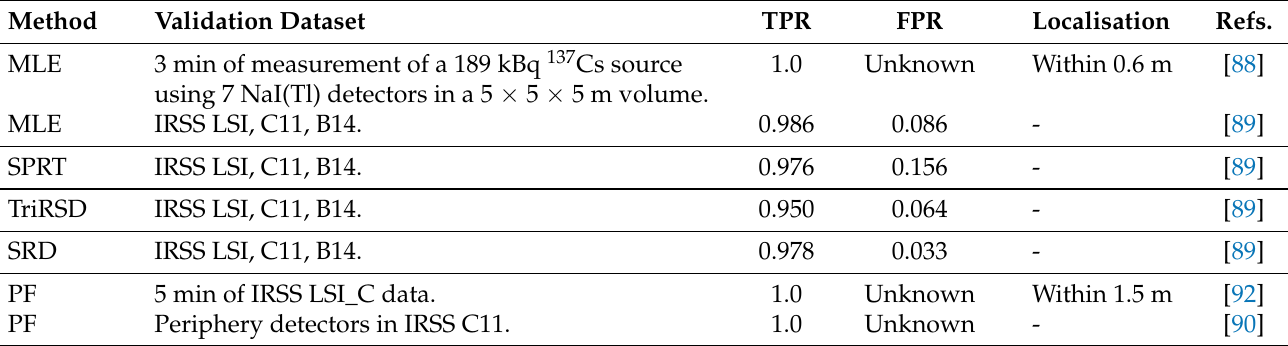
Table 4. Comparison of algorithms used to process measurements taken by a spatially distributed radiation detector network. Method Validation